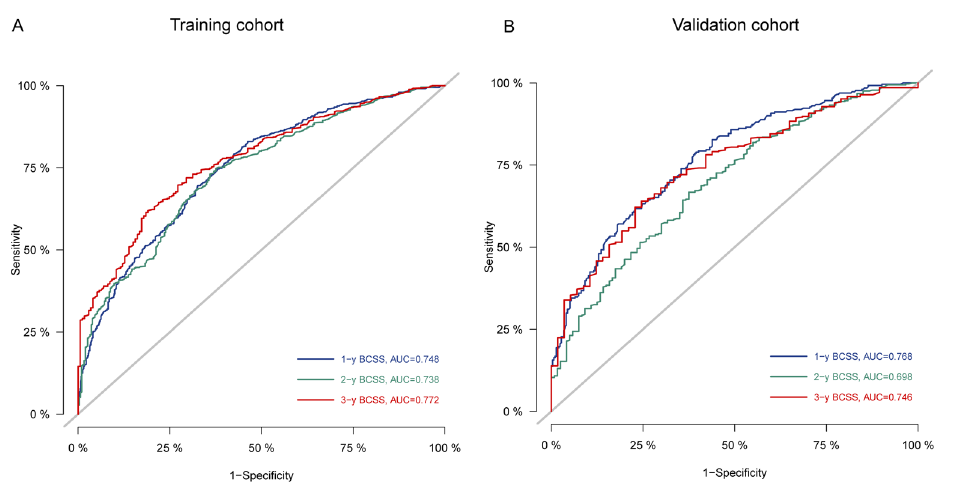
Figure 4. ROC curves and AUC for 1-, 2-, and 3-year BCSS in training ( A ) and validation ( B )